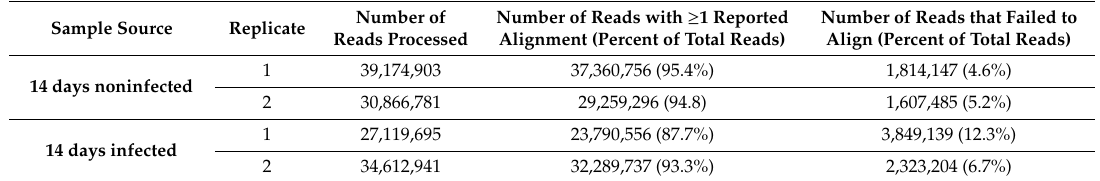
Table 1. RNA-seq generated more than 60 million reads in both groups. Among these reads, Bowtie v2.2 and TopHat v2.1 mapped at least 87.7% of the reads to the reference genome. At least one successfully aligned read was required for inclusion.